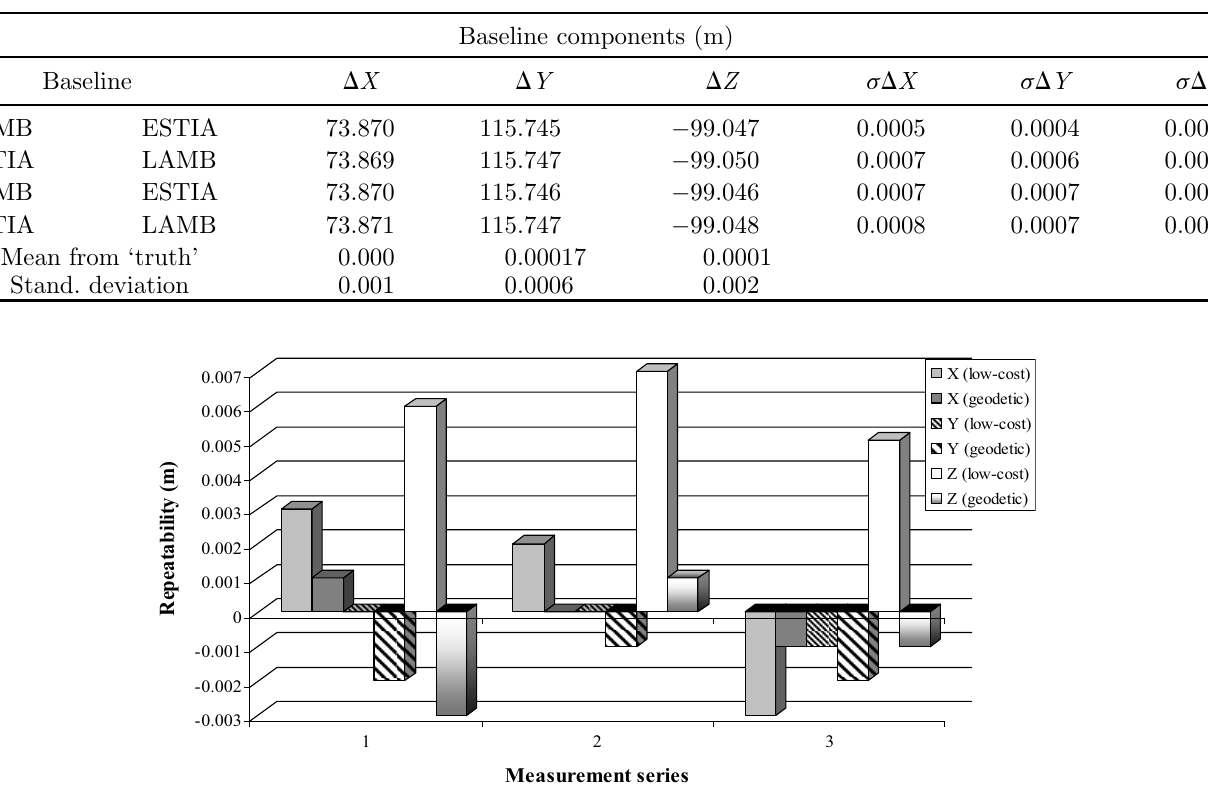
Table 5b. Baseline repeatability (geodetic receivers).